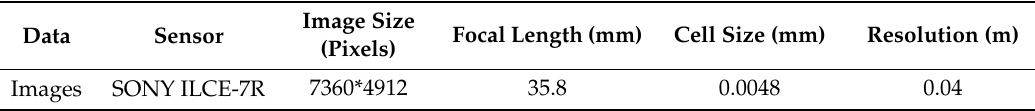
Table 1. Detail information of UAV images.